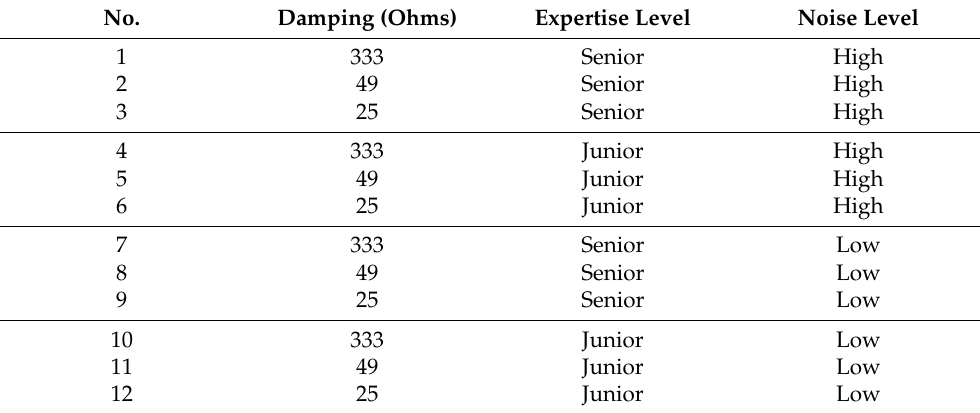
Table 1. Experiment conditions including different experimental setups, human factors, and environ- mental factors. No. Damping (Ohms) Expertise Level Noise Level